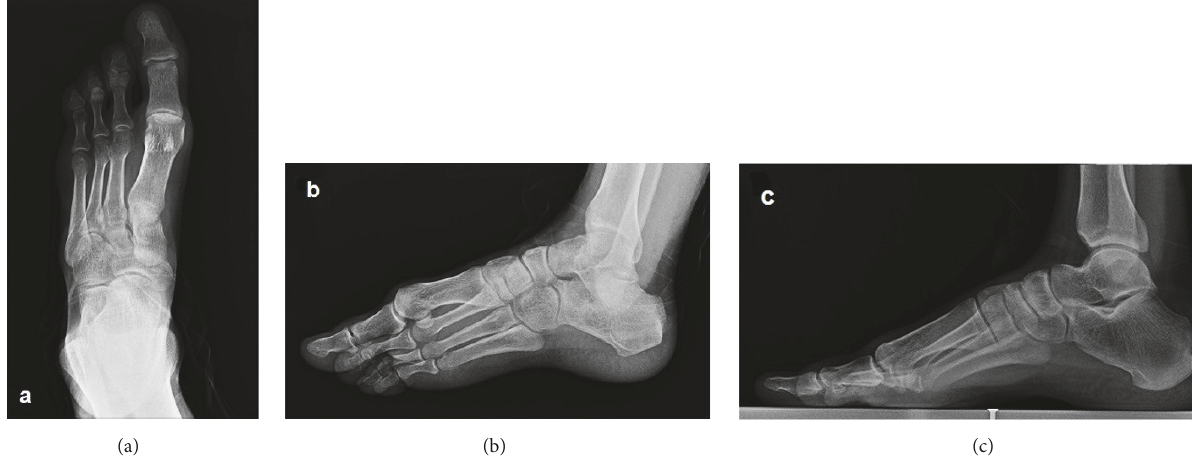
Figure 4: Anteroposterior (a), lateral oblique (b), and mediolateral (c) radiographs of the left foot demonstrate the absence of the fifth finger and the lateral cuneiform. The second to fourth fingers are short. The number, size, and joint relations of the other bones forming the foot are